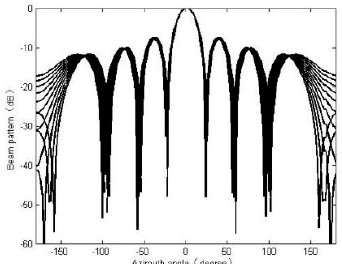
Figure 6. Broadband beam pattern focused on a frequency of 2760 Hz after robust Capon beamforming (RCB) correction.